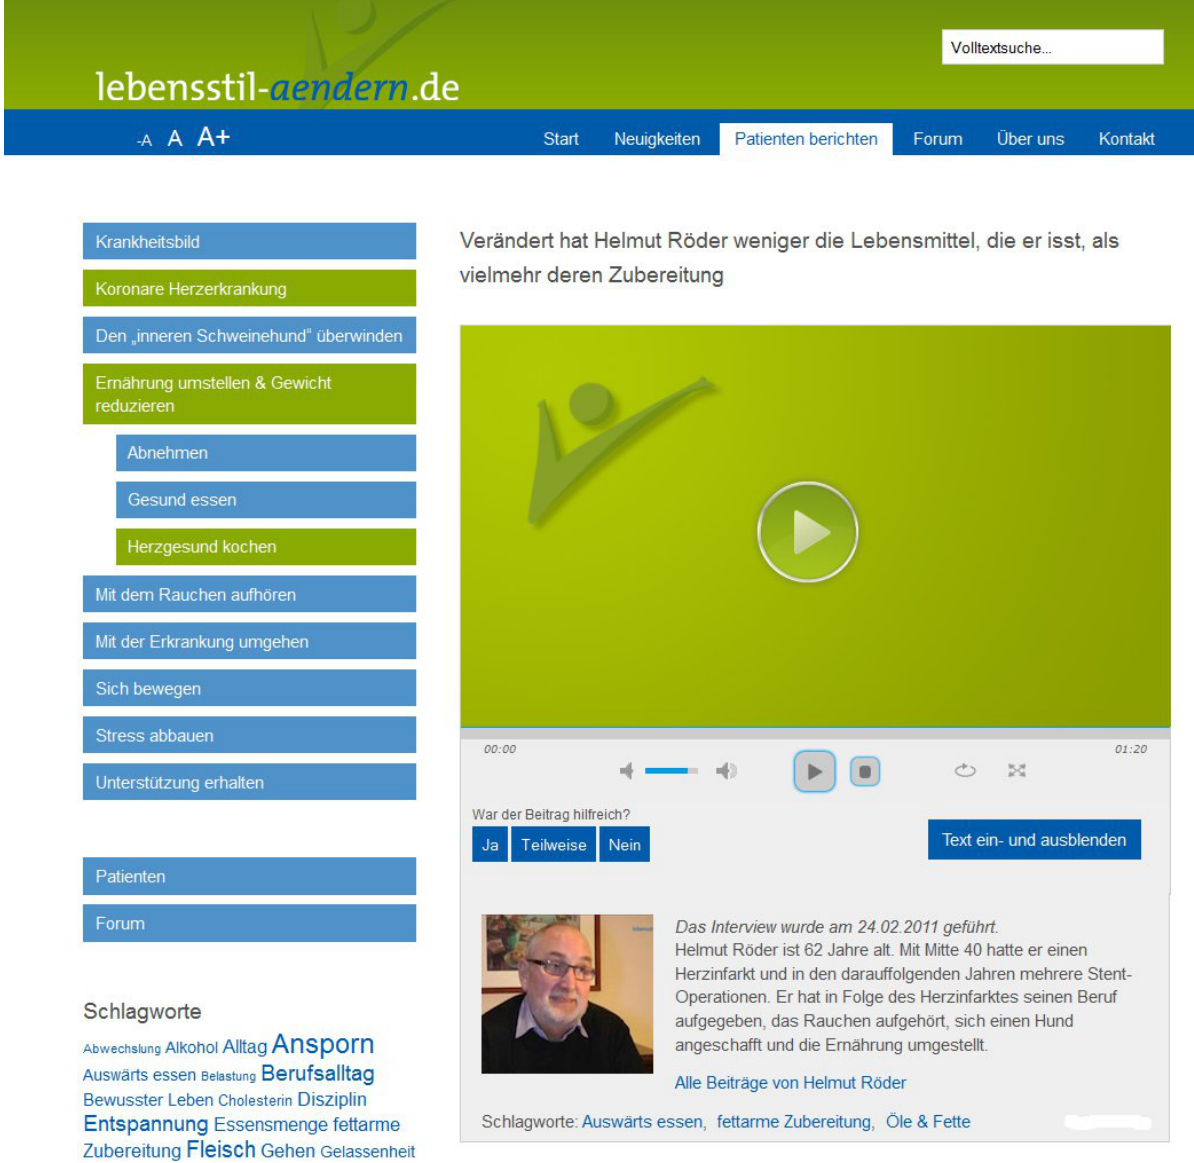
Figure 2. Screenshot of a video subpage from the coronary heart disease module. On the left side is the vertical menu with the tag cloud beneath. Below the video player are buttons for evaluation and short information text about the patient’s health